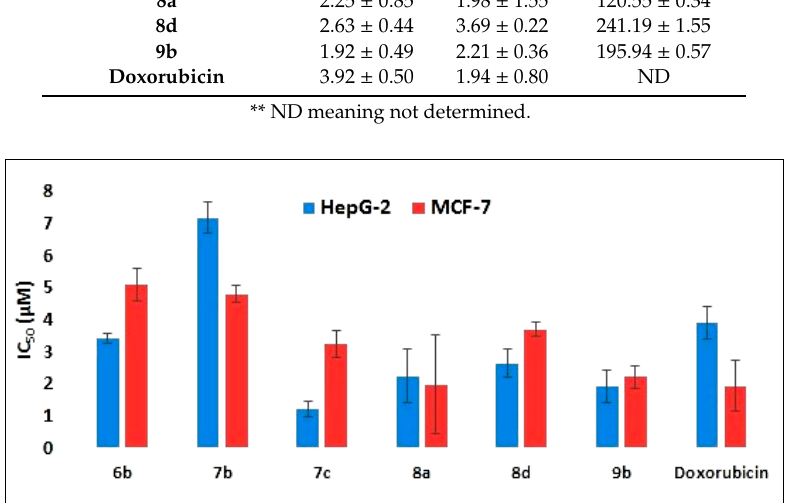
Figure 2. The antiproliferative activities (IC 50 , µM) of the Schiff bases and doxorubicin against HepG-2 and MCF-7 cell lines.